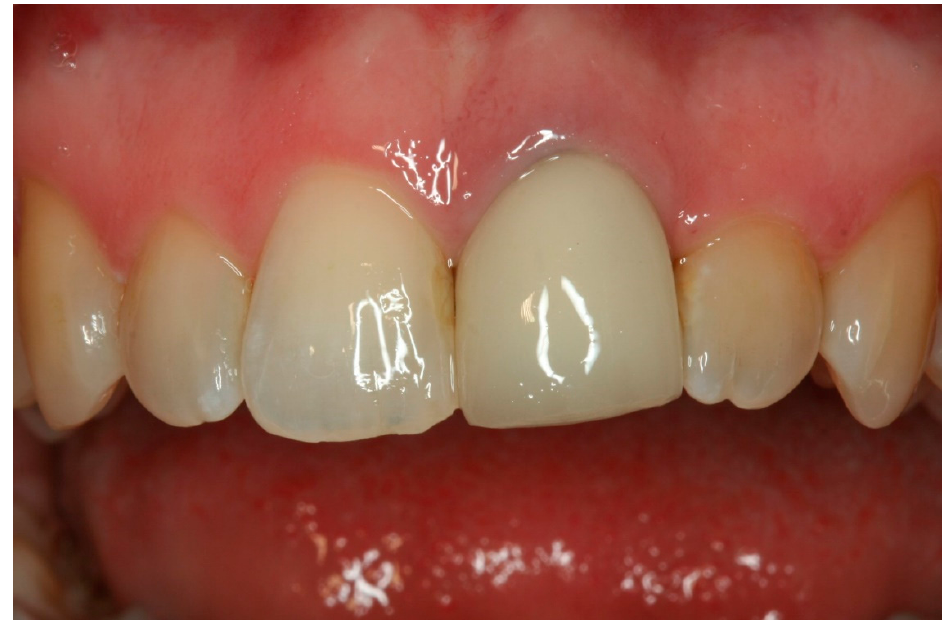
Figure 1. Preoperative presentation: Failing 21.